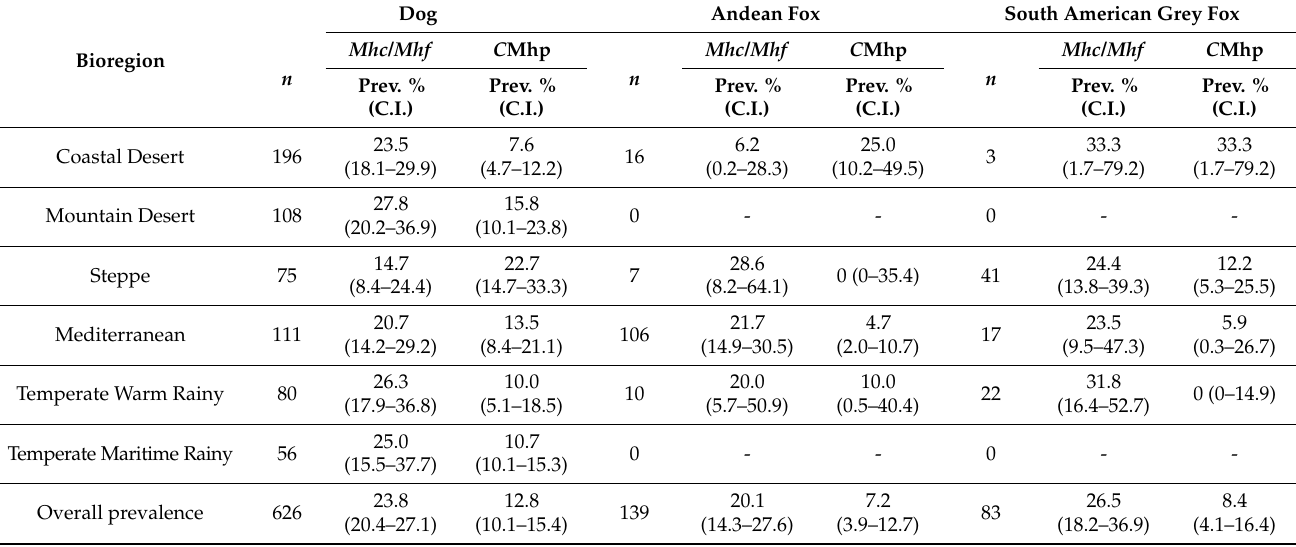
Table 2. Hemoplasma prevalence in rural dogs and foxes per bioclimatic regions in